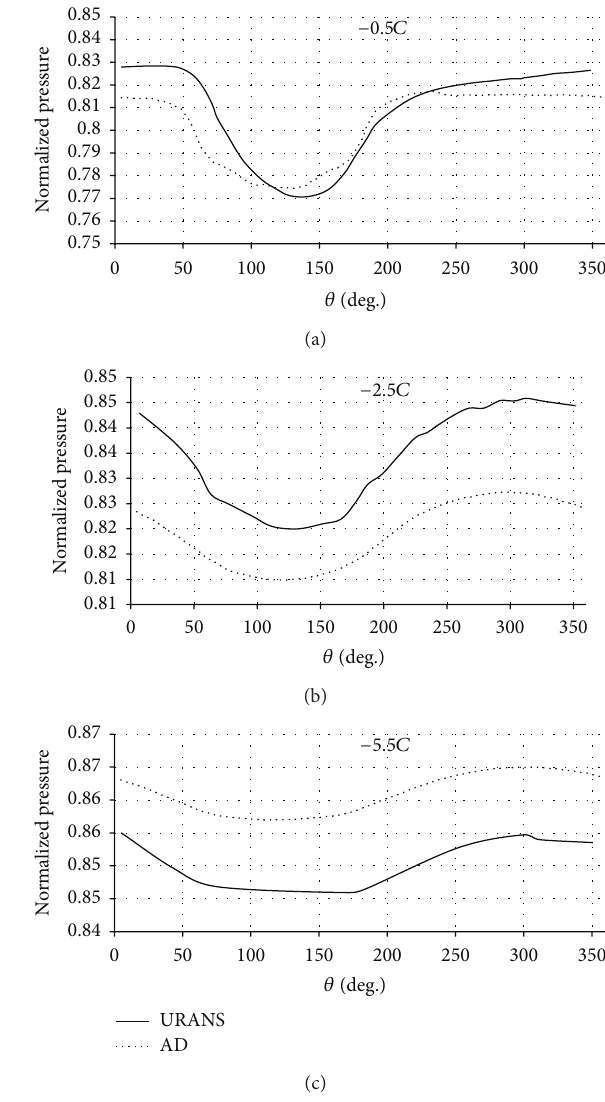
Figure 10: Comparison of the static pressure for 3 reference planes.